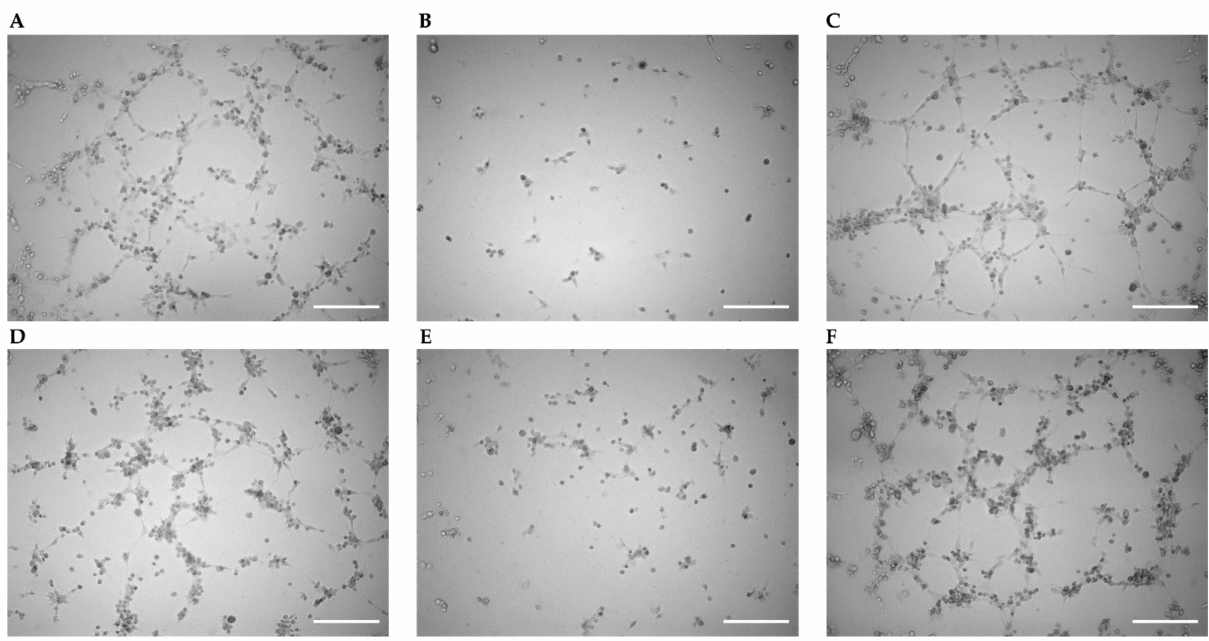
Figure 3. Angiogenesis assay in different treatment groups. Representative images obtained 6 h after the start of the tube formation assay are shown for non-treated HUVECs ( A ), cells transfected with an empty vector ( B ) or with Cx43 cDNA ( C ), cells treated with scrambled siRNA ( D ) or Cx43 siRNA ( E ), and cells transfected with Cx43 cDNA followed by Gap27 application ( F ). Scale bar is 250 µ